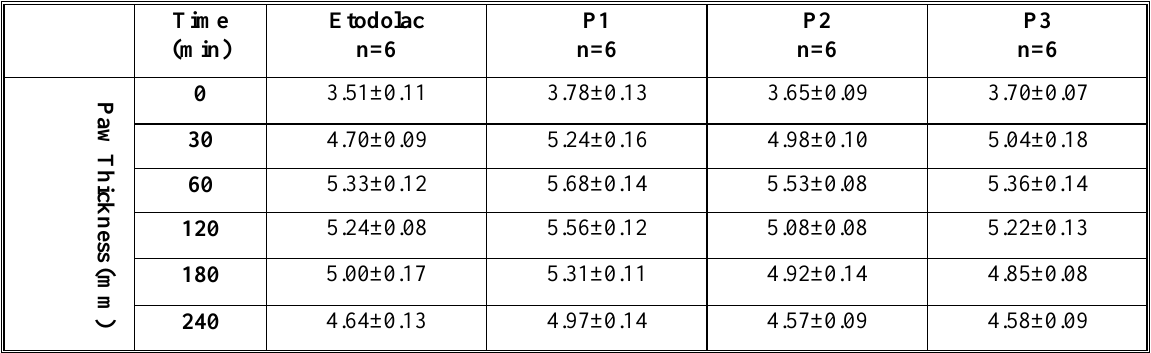
Table (3) Effect of etodolac (reference) and target compounds (P1-P3) on egg-white induced paw edema